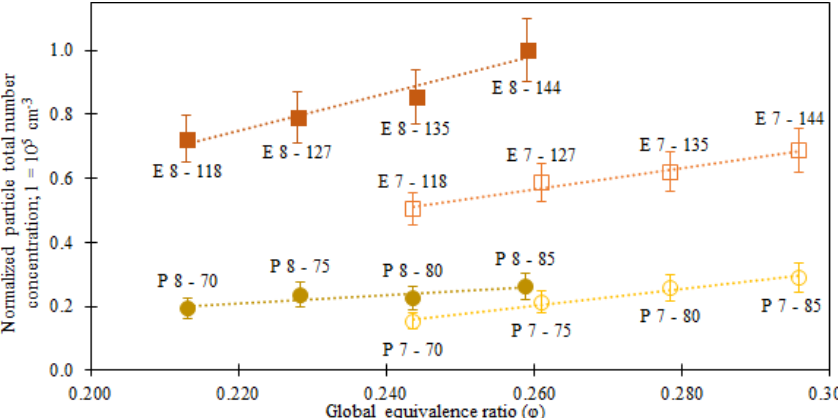
Figure 4. Particle number concentration vs. the global equivalence ratio. Values are normalized to the highest of the whole set. Each point is labelled with E or P (ethylene or propane) and a pair of numbers indicating air and fuel flow rate, respectively (Lmin − 1 ; mLmin − 1 ). Dotted lines aim to guide the reader’s